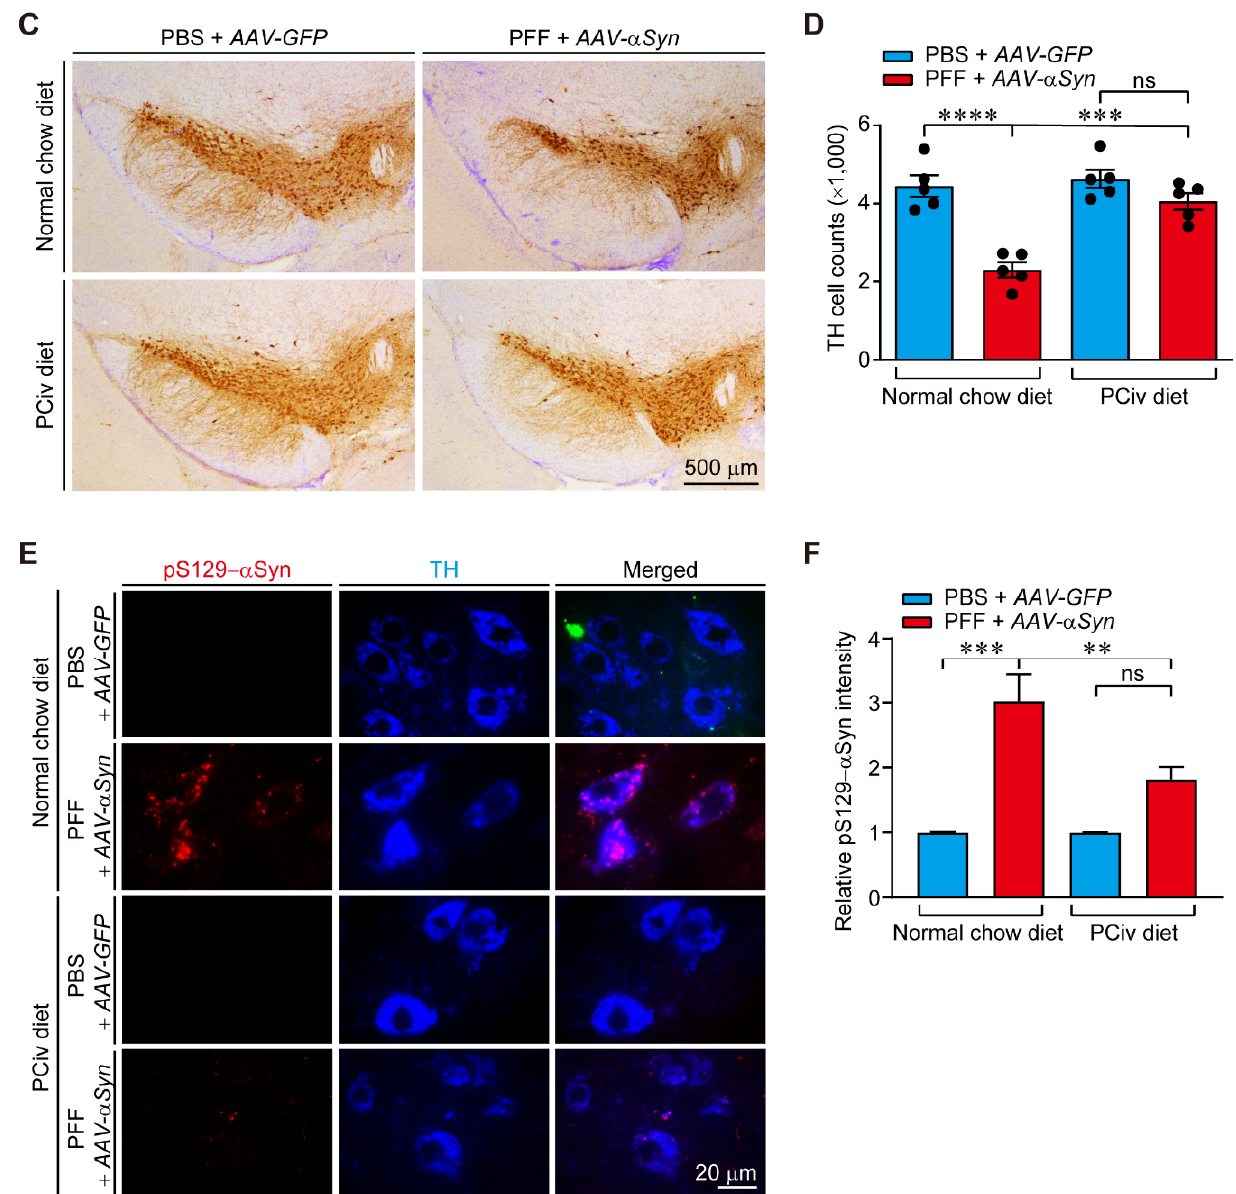
Figure 4. PCiv administration suppresses PFF-induced dopaminergic neurodegeneration, α -synuclein aggregation, and motor dysfunction in vivo. ( A ) Bradykinesia (slowness of movement) assessed by pole test for control and combinatorial PFF/ AAV- α Syn -injected mice with or without PCiv treatment (50 mg PCiv/kg diet for 30 days, n = 5 per group). Control mice are those nigrally injected with PBS and AAV-GFP . ( B ) Motor coordination of the mice in the experimental group was assessed by an accelerated rotarod test ( n = 5 per group). ( C ) Representative tyrosine hydroxylase (TH) immunohistochemical staining of the ventral midbrains of control and combinatorial α -synucleinopathy-PD mice fed with a PCiv diet (50 mg/kg diet for 30 days) or normal chow diet. ( D ) Stereological assessment of TH-positive dopaminergic neurons in the substantia nigra pars compacta of the injection side of the indicated mice groups ( n = 5 mice per group). ( E ) Representative immunofluorescence images of pS129- α Syn and TH in the substantia nigra coronal sections of the indicated experimental mice groups. ( F ) Quantification of relative pS129- α Syn fluorescence intensities in the TH-positive dopamine neurons of the substantia nigra sections from the indicated experimental groups ( n = 28 cells from 3 mice per group). The quantified data are expressed as means ± SEMs. Statistical significance was determined by an ANOVA test with Tukey’s post hoc analysis, ** p < 0.01, *** p < 0.001, and **** p < 0.0001. ns =